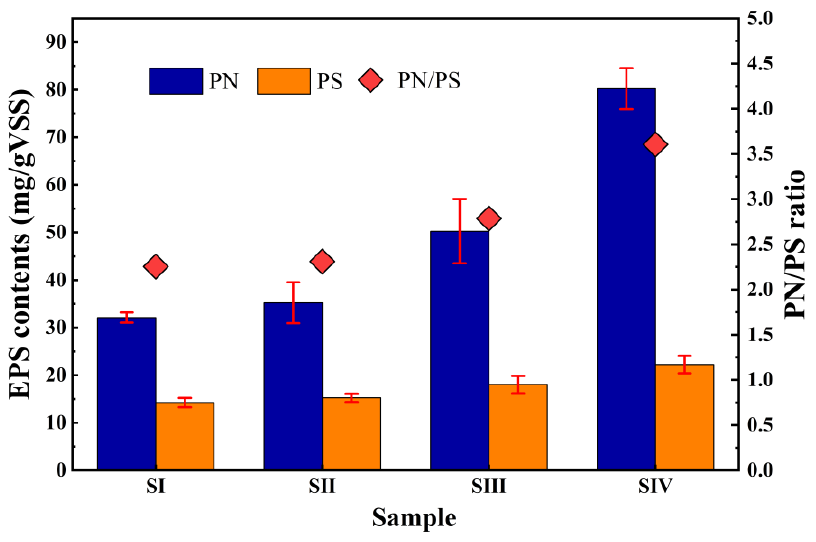
Figure 3. Changes in EPS contents and PN/PS ratio at the different